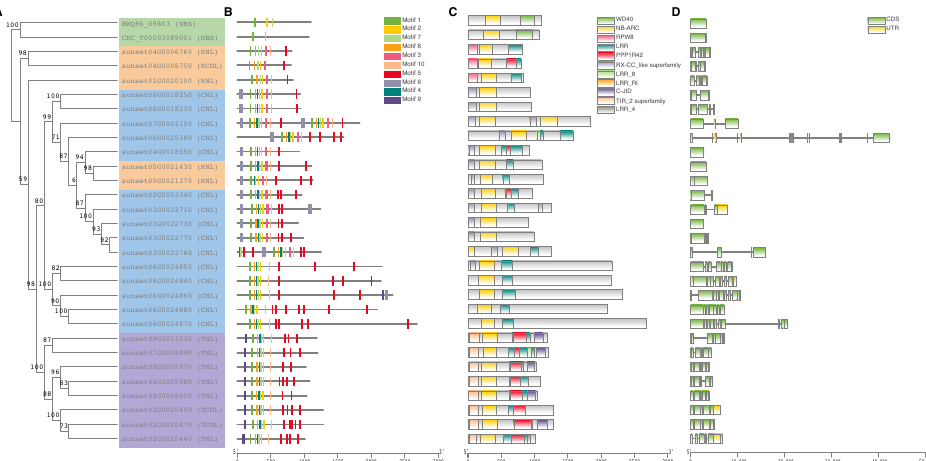
Figure 4. Phylogeny, conserved motifs, domains, and gene structures of papaya NLRs (CNL, RNL, TNL). ( A ) Phylogeny of papaya NLRs. NBS genes from Rhodophyta were used as the outgroup. The numbers at the nodes mean branch support values, which are evaluated by the Shimodaira– Hasegawa test. Green indicates the NBS subclass. Orange indicates the RNL subclass. Blue indicates the CNL subclass. Purple indicates the TNL subclass. ( B ) Conserved motifs of papaya NLRs. ( C ) Conserved domains of papaya NLRs. ( D ) Gene structures of papaya